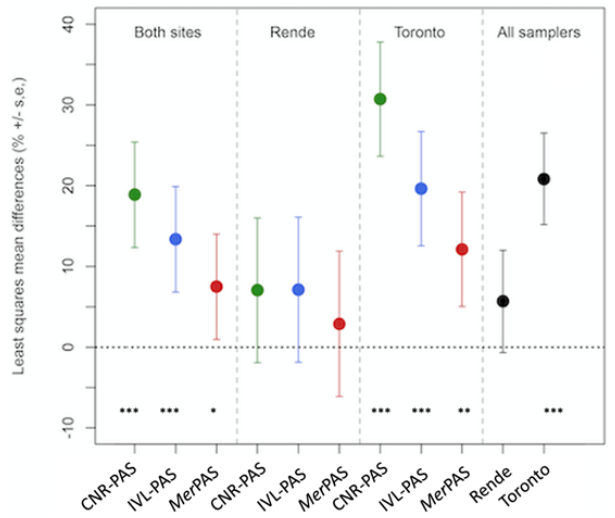
Figure 4. Least square means and standard errors of the differences in concentrations measured by the PASs and by the Tekran units. Results are shown either for each PAS individually (colored mark- ers) or for the three PASs together (black markers). They are also shown either separately for the two sampling sites or both of them together. The asterisks below each bar indicate whether or not the least square mean concentration differences from that “dataset” dif- fered significantly from 0 (where ∗∗∗ denotes p ≤ 0 . 001, ∗∗ denotes p ≤ 0 . 01, and ∗ denotes p ≤ 0 .